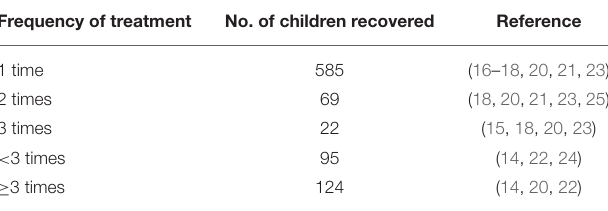
TABLE 3 | Summary of treatment frequency and number of recovery. Frequency of